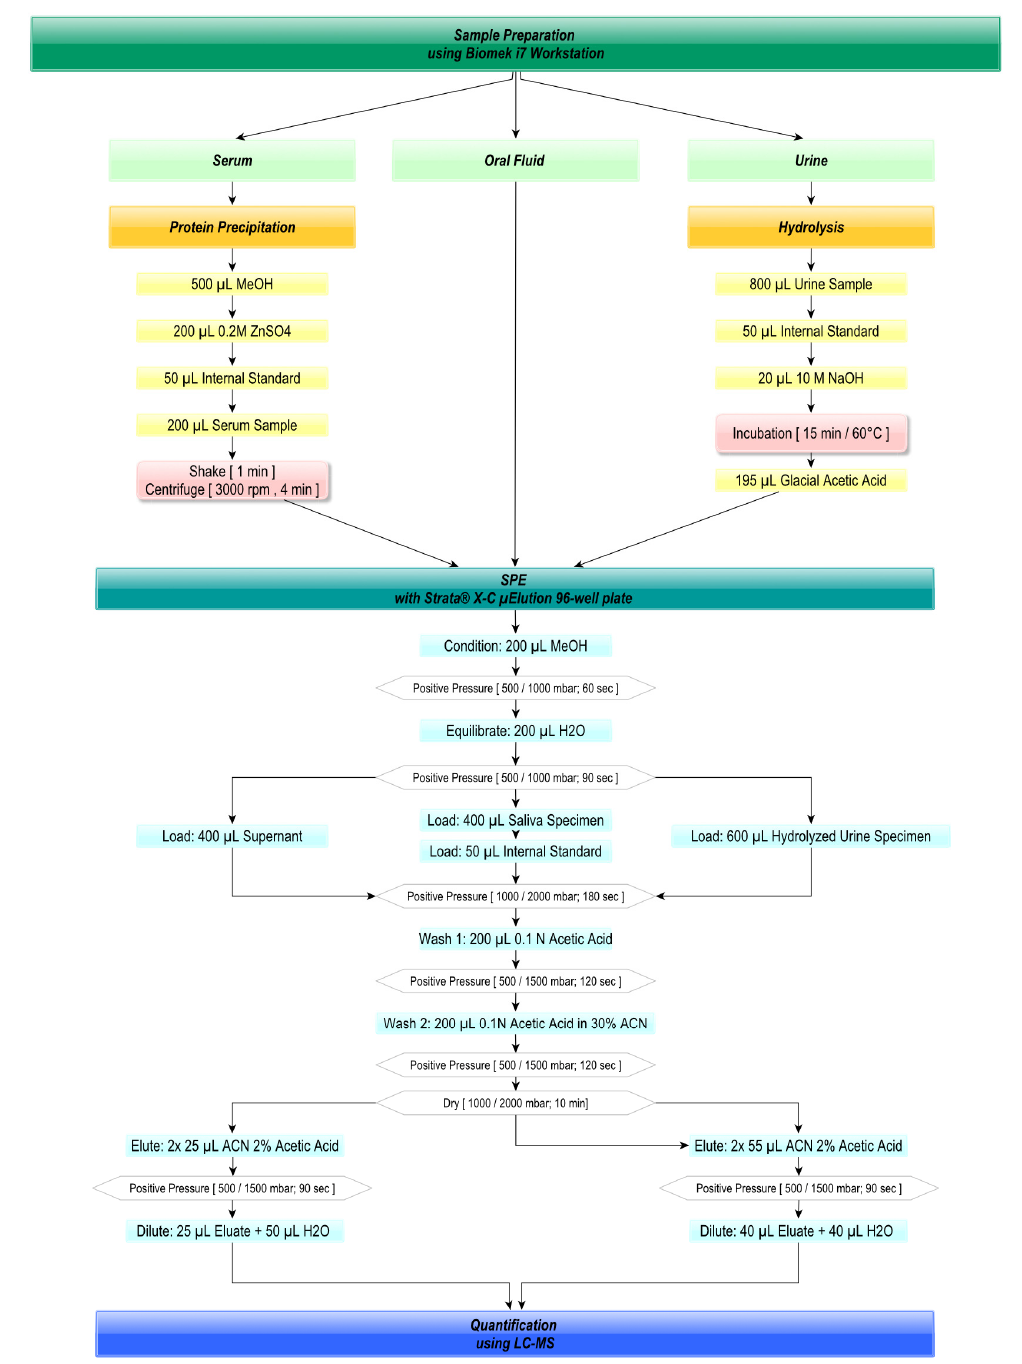
Figure 2. Sample Preparation Process.